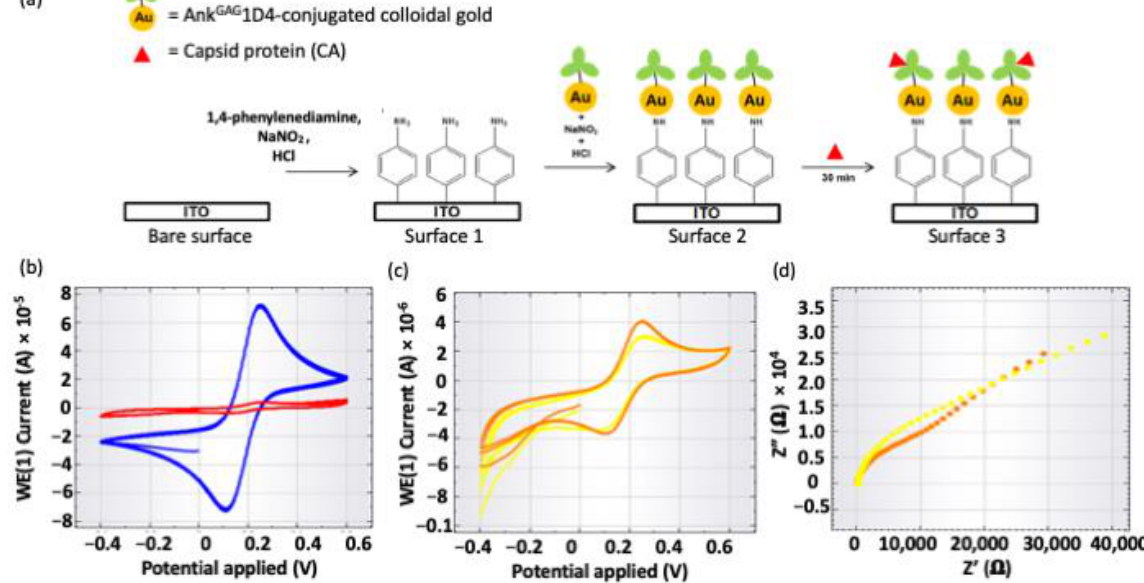
Figure 5. Simple stepwise of ( a ) fabrication of ITO surface used for detecting binding of CA, and the cyclic voltammograms of the ( b ) bare ITO surface (blue) and Surface 1 (red), ( c ) Surface 2 (orange) and Surface 3 (yellow), and ( d ) the Nyquist plots obtained from the EIS measurements for Surface 2 (orange) and Surface 3 (yellow).